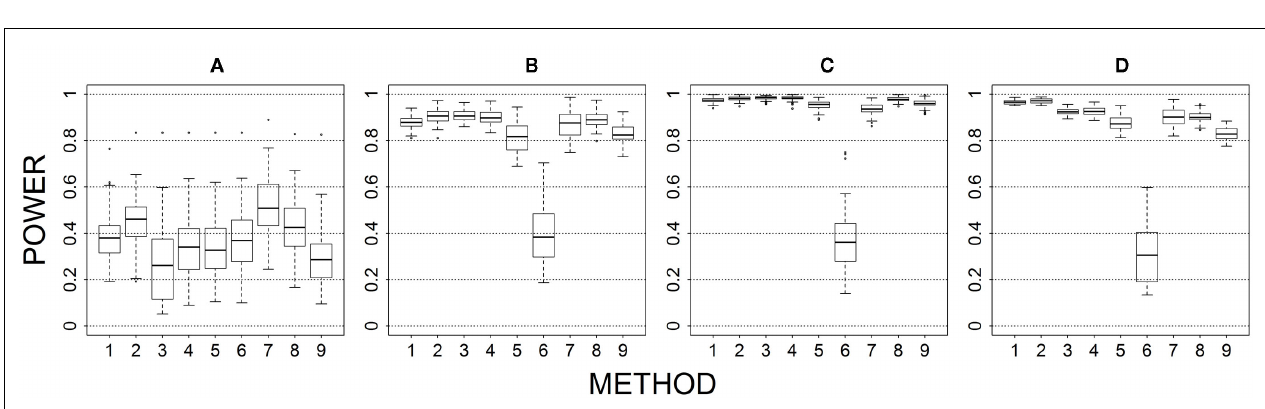
FIGURE 3 | Power results for multiple causal alleles in a locus with same effects under 4 loci out of 12 markers setting for binary trait. Power is calculated over 500 replicate data sets with α = 0.05; there are 165 possible combinations of 4 causal loci out of 12 markers; boxplots summarize the